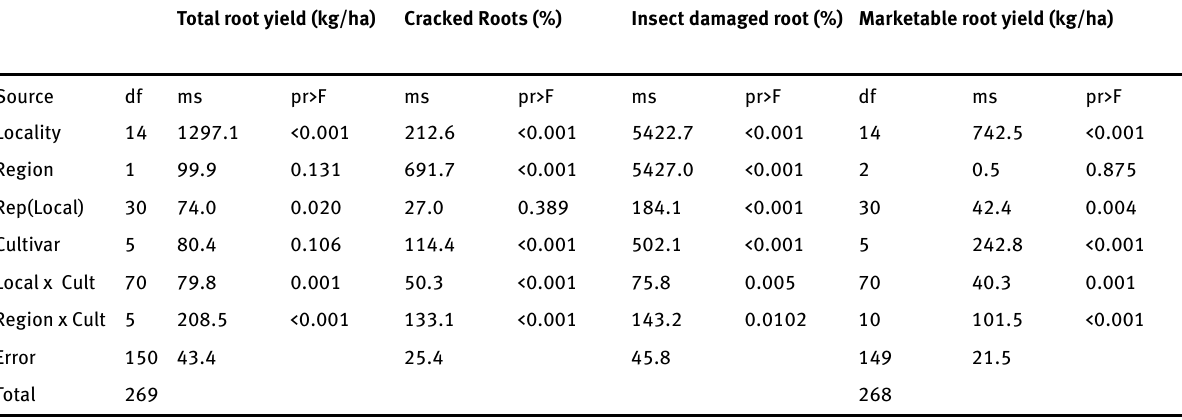
Table 3: Combined analysis of variance of a series of on-farm cultivar demonstration trials in 15 locations Total root yield (kg/ha)